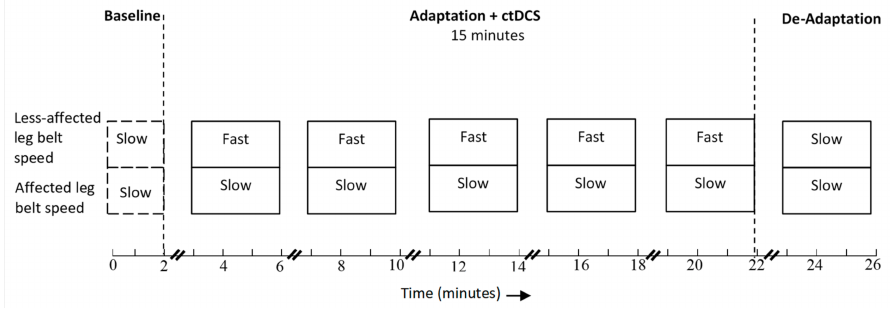
Figure 2. Split-belt treadmill training